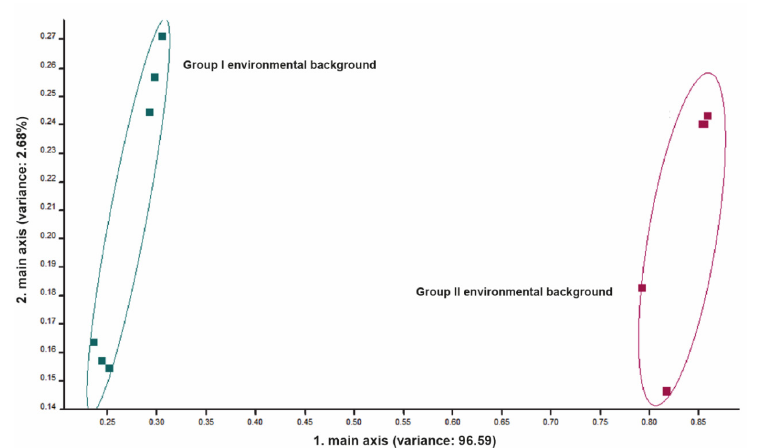
Figure 4. Principal component analysis (PCA) for environmental background of group I and group II. Note the high discrimination between the two environmental backgrounds. The numbers in pa- rentheses indicate the percentages of the data matrix described by the relevant components and functions. and functions.